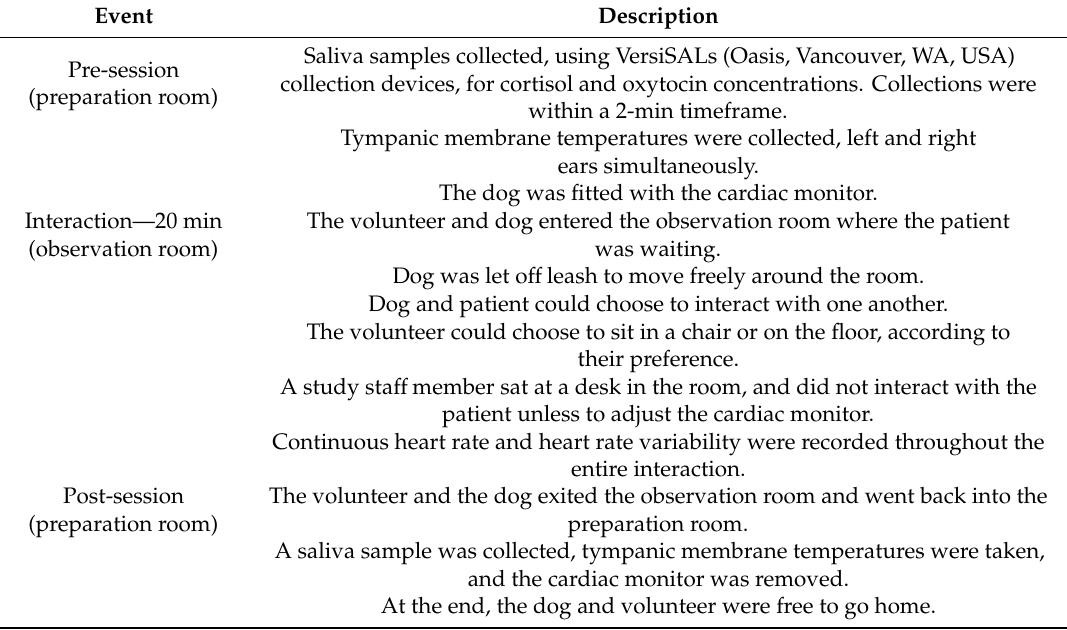
Table 2. Outline of general methods during a 20-min interaction with a therapy